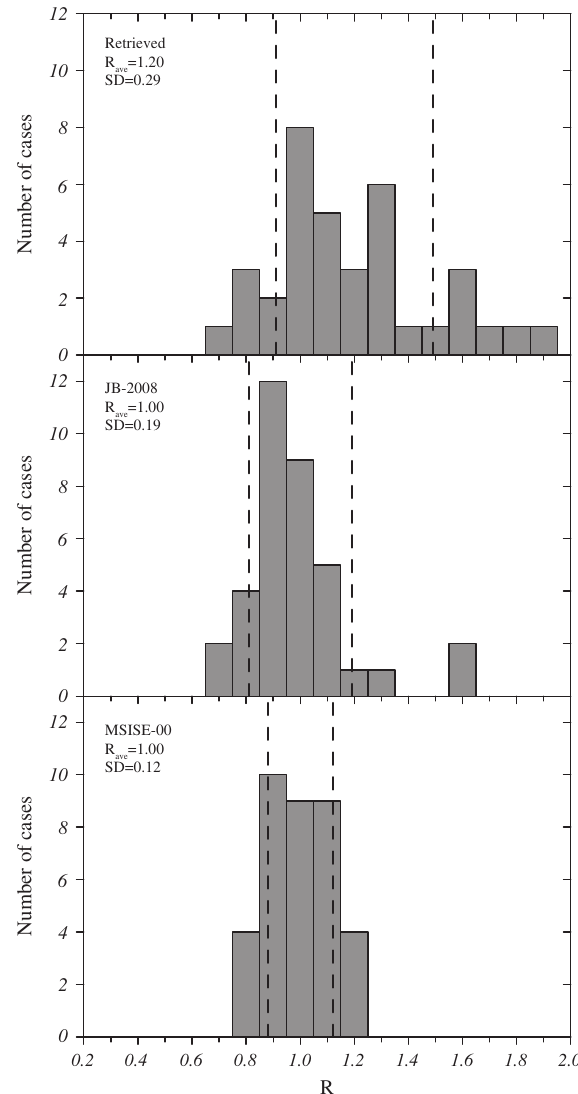
Fig. 3. Same as Figure 1 but for solar maximum